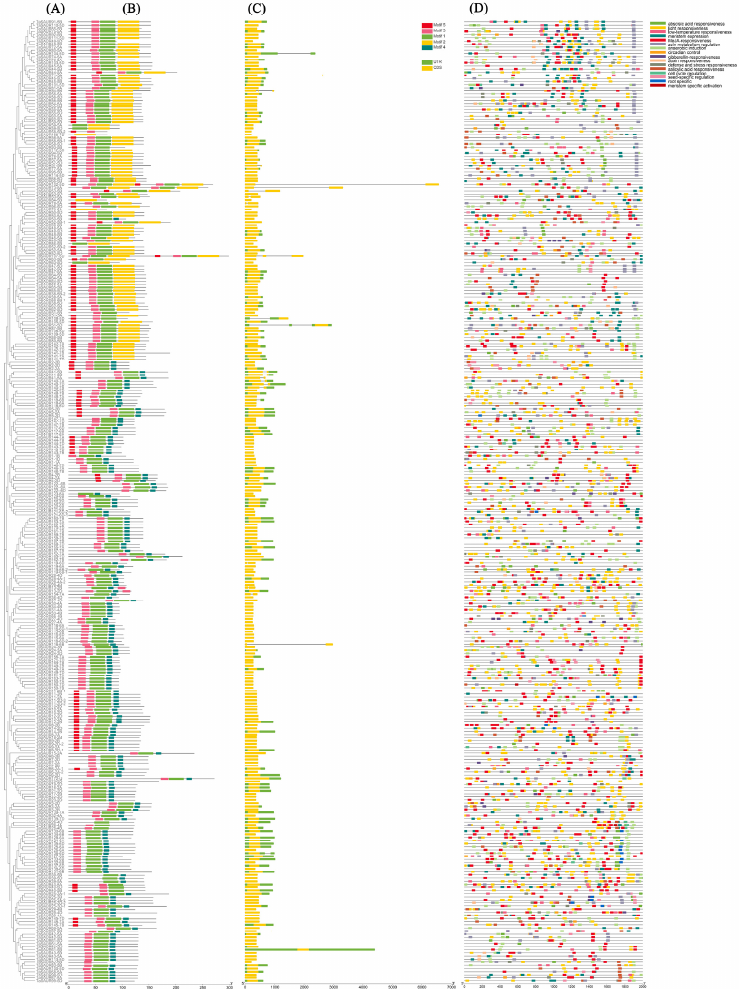
Figure 2. Phylogenetic relationship, motif distribution, gene structure, and cis-element analysis of the TaSAUR proteins and TaSAUR genes. ( A ) The phylogenetic tree was constructed using the neighbor- joining method with MEGA 7.0. ( B ) The conserved motifs were predicted using Multiple Em for Motif Elicitation (MEME) (https://meme-suite.org/meme/tools/meme (accessed on 20 January 2022)). The box length indicates the number of amino acids in the motif. ( C ) The structure of TaSAUR genes. Yellow boxes represent exons, lines represent introns, and green boxes represent untranslated regions (UTRs). ( D ) The 2 000 bp DNA fragments in the upstream of the coding region of TaSAUR genes were selected as putative promoter regions for cis-element analysis using the PlantCARE online tool. Each color indicates one kind of